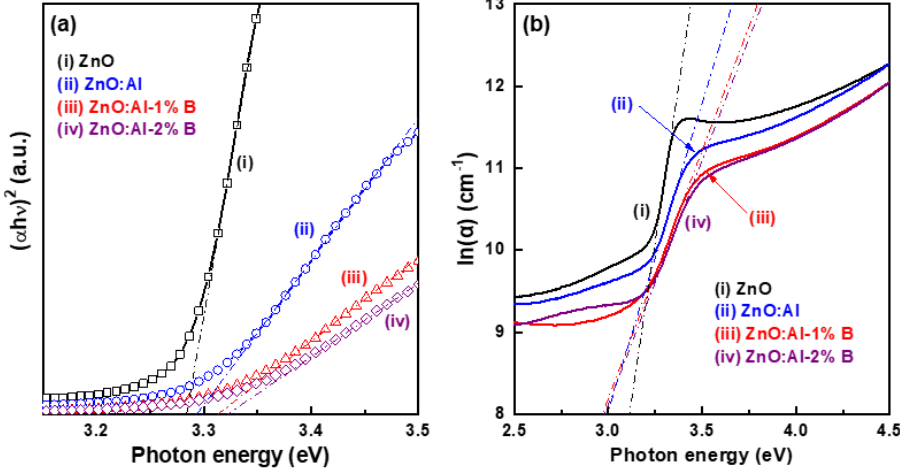
Figure 6. ( a ) Plot of ( α h ν ) 2 versus photon energy, h ν (eV) and ( b ) plot of ln ( α ) versus photon energy, h ν (eV) of ZnO, ZnO:Al and ZnO:Al-B thin film samples. The refractive index (n) of the thin films is related to reflectance ( R ), transmittance ( T ) and extinction coefficient ( k ) and is determined by the following formula